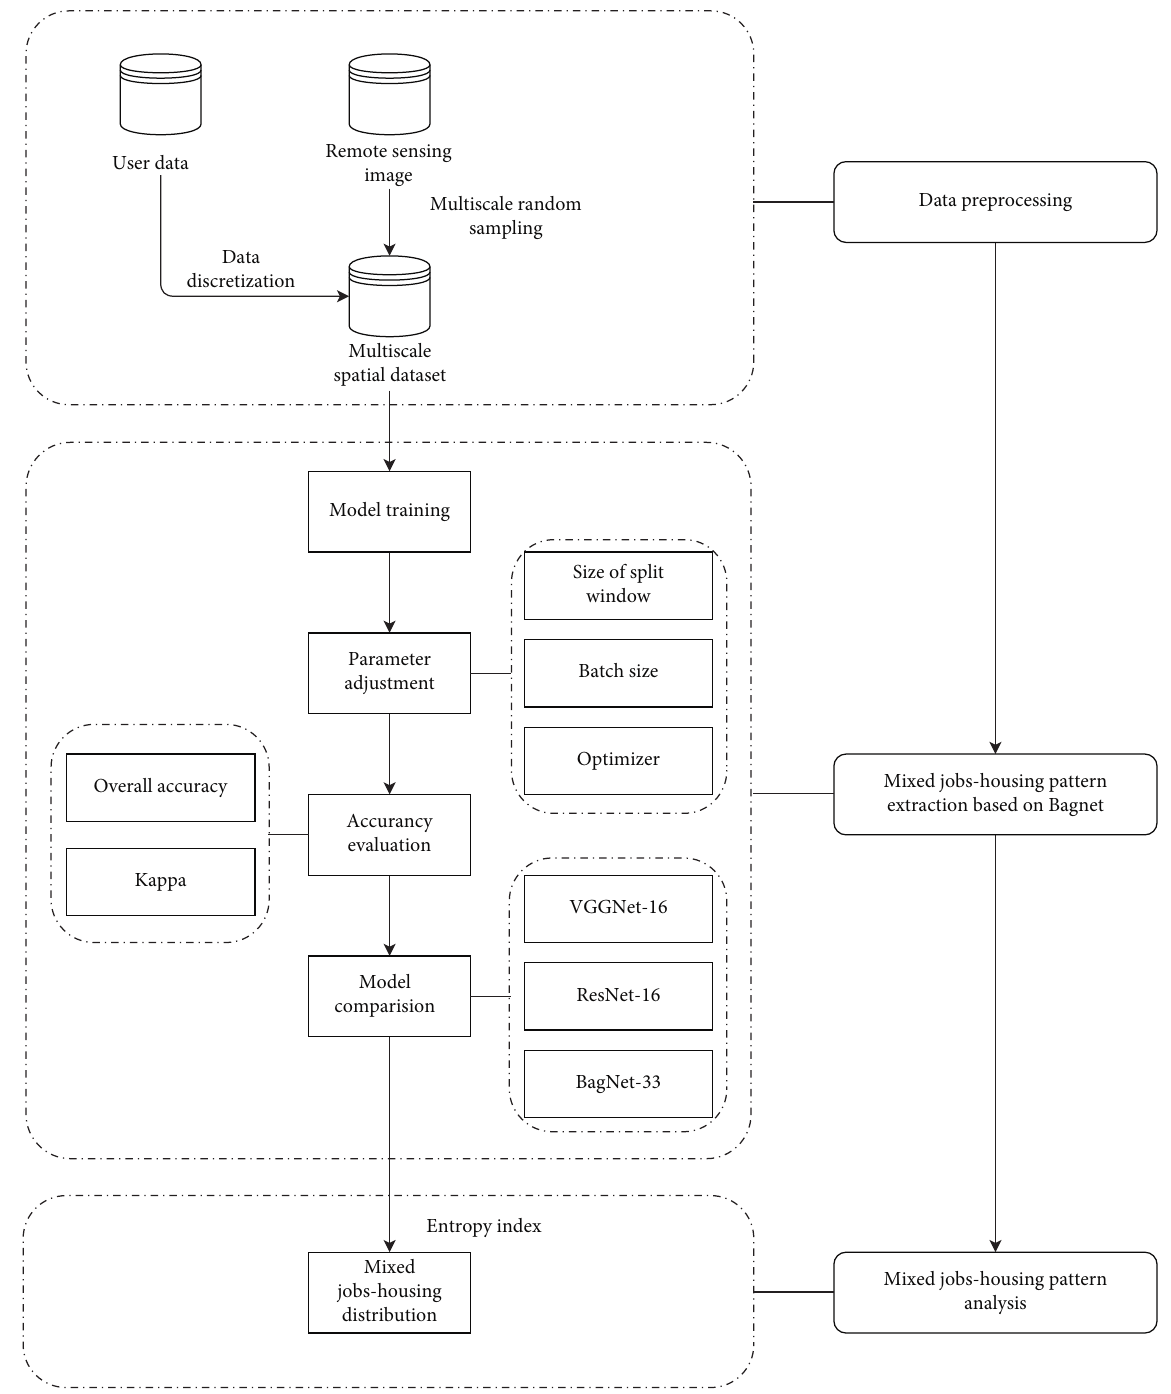
Figure 5: The workflow of jobs-housing mixed analysis based on